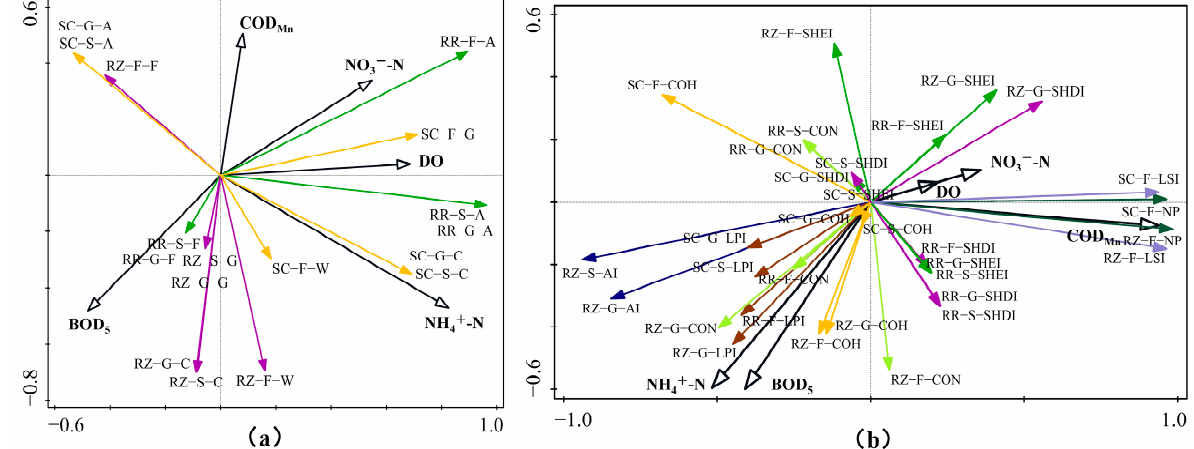
Figure 7. Sequence diagram of RDA results of different landscape features and RWQ in different scales (( a ): landscape type; ( b ): landscape indices). Note: The naming method in above figure was “spatial scale–slope scale–landscape type (landscape